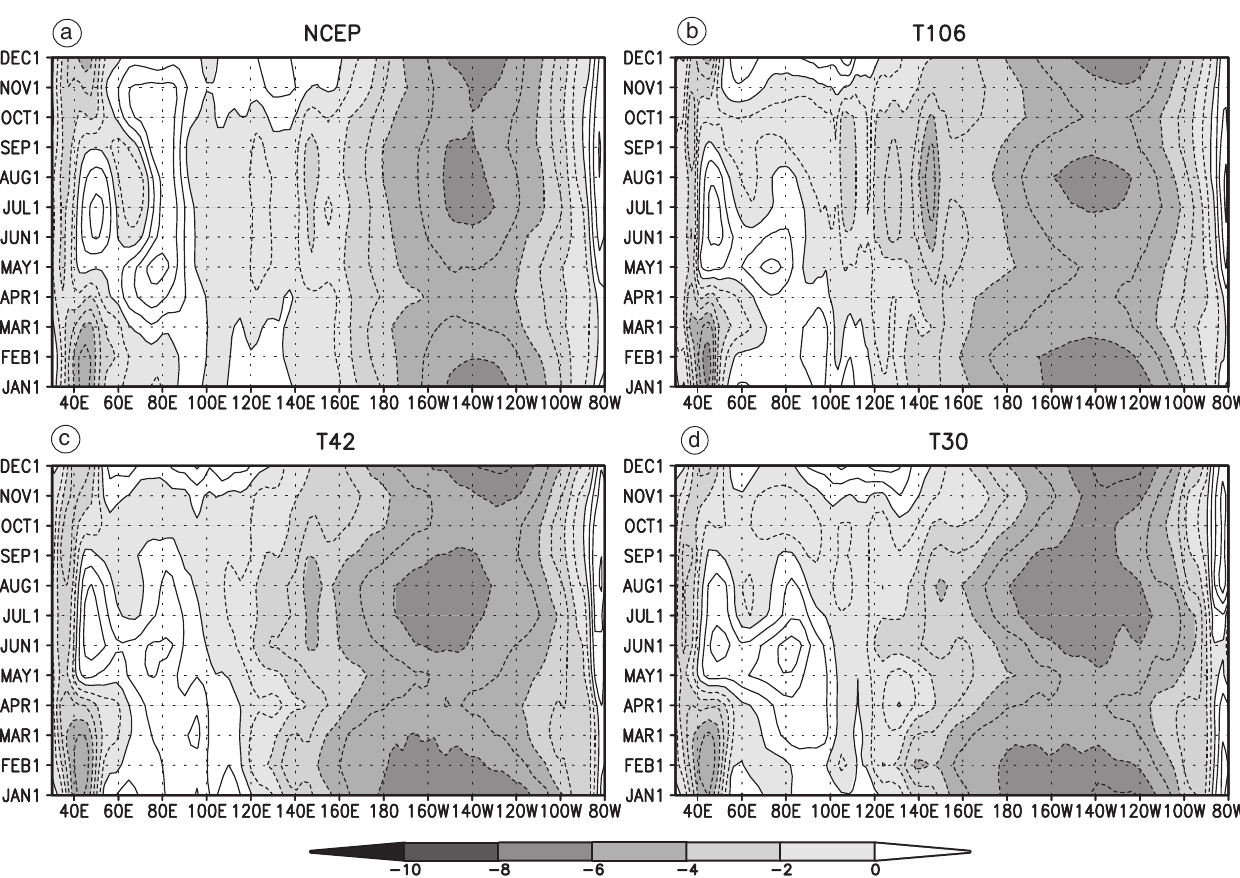
Fig. 8a-d. Seasonal cycle of the l000-hPa zonal wind along the equator (averaged between 5 ° S and 5 ° N) in the Indian Ocean and Pacific. Panel a): as derived from the NCEP re-analysis; panel b): T106 experiment; panel c): T42 experiment; panel d): T30 experiment. Contour line interval is 1 m/s. Dashed contour lines and shaded areas indicate negative values; shaded contour interval is 2